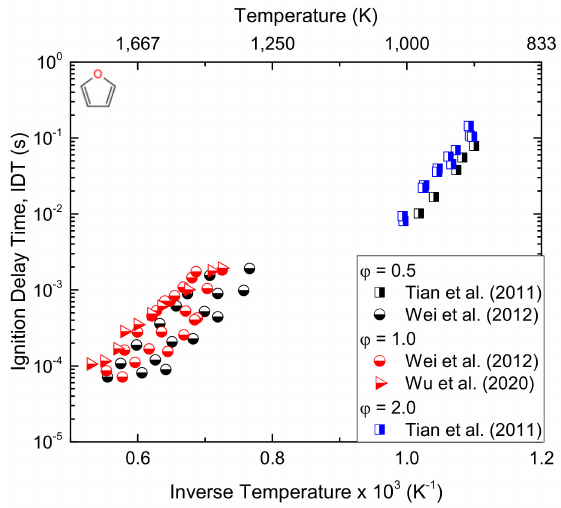
Figure 14. Ignition delay time data for the furan/air mixture under different conditions.